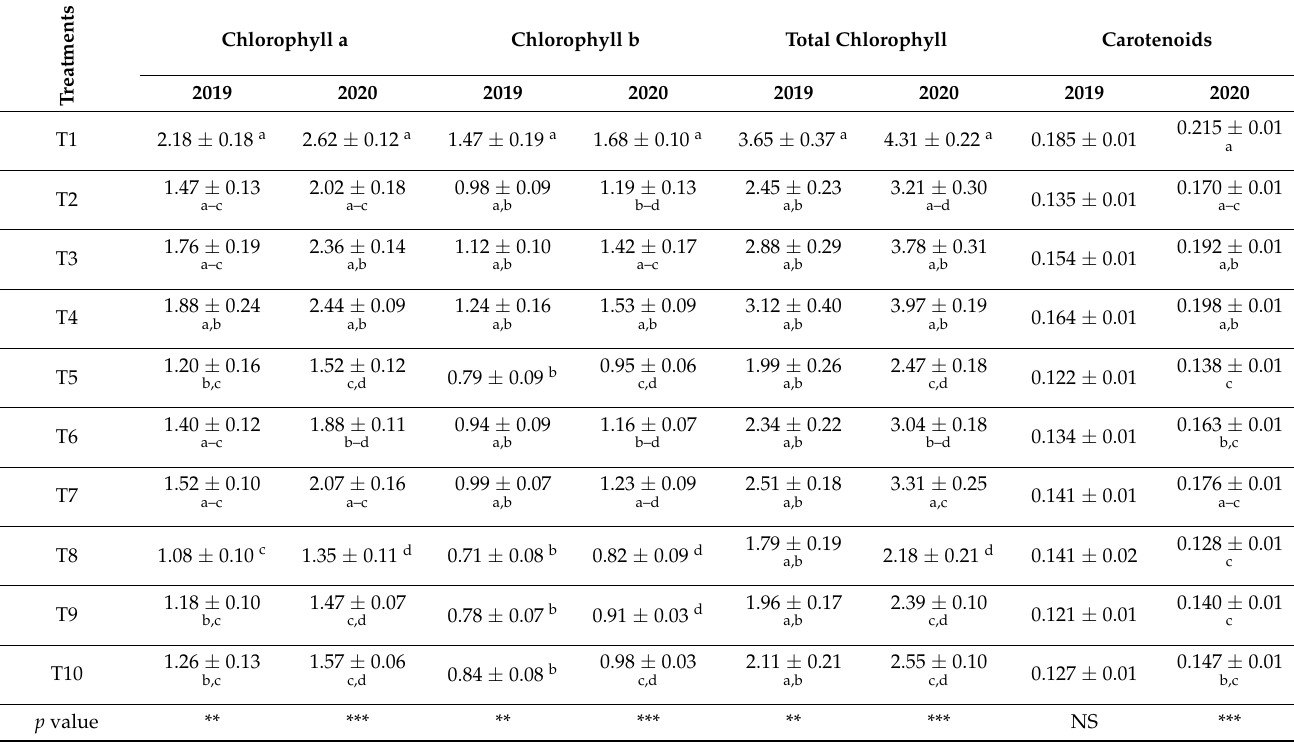
Data represent the average of five replicates ± standard error. Different letters in each column indicate significant ( p ≤ 0.05) differences at p ≤ 0.05 according to Tukey’s HSD range at p ≤ 0.05. Levels of significance are represented by ** p < 0.01 and *** p < 0.001; NS, nonsignificant. (T1, 0 NaCl without BL application; T2, 1000 mg L − 1 NaCl without BL application; T3, 1000 mg L − 1 NaCl with 1 mg L − 1 BL application; T4, 1000 mg L − 1 NaCl